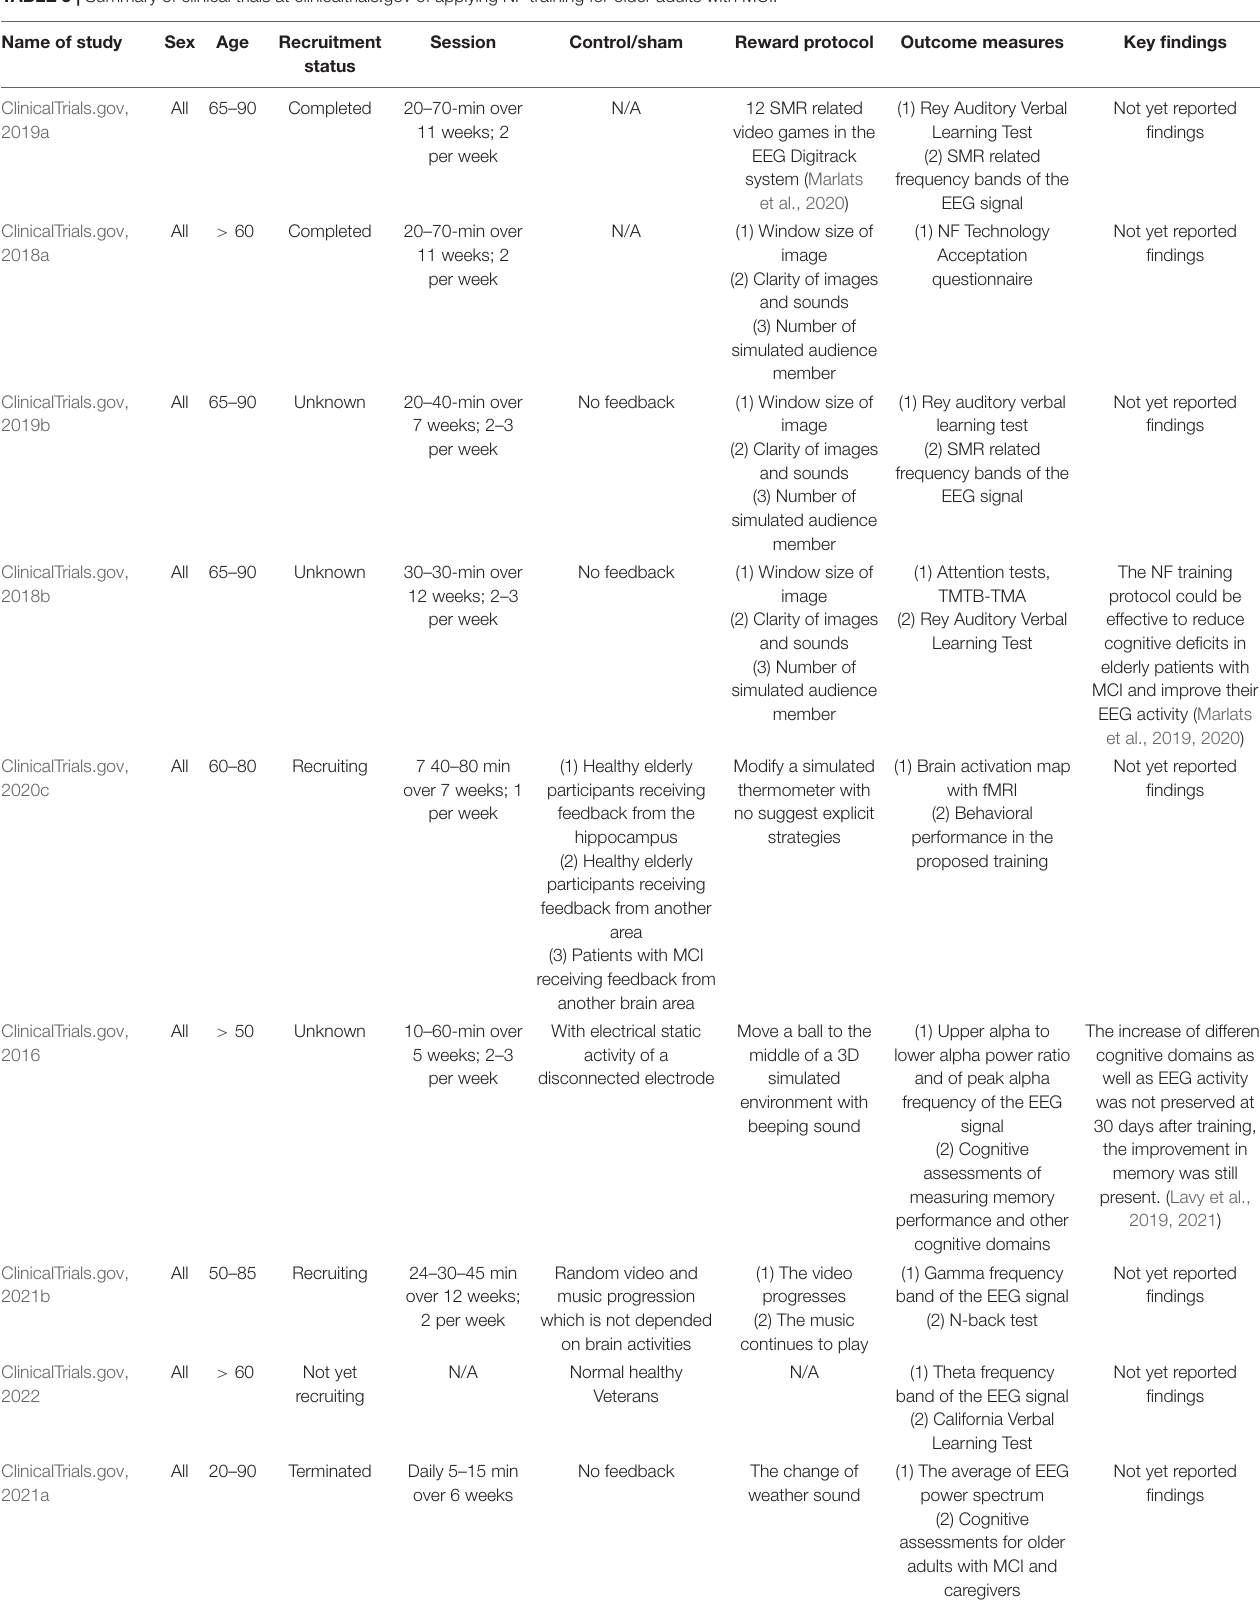
TABLE 5 | Summary of clinical trials at clinicaltrials.gov of applying NF training for older adults with